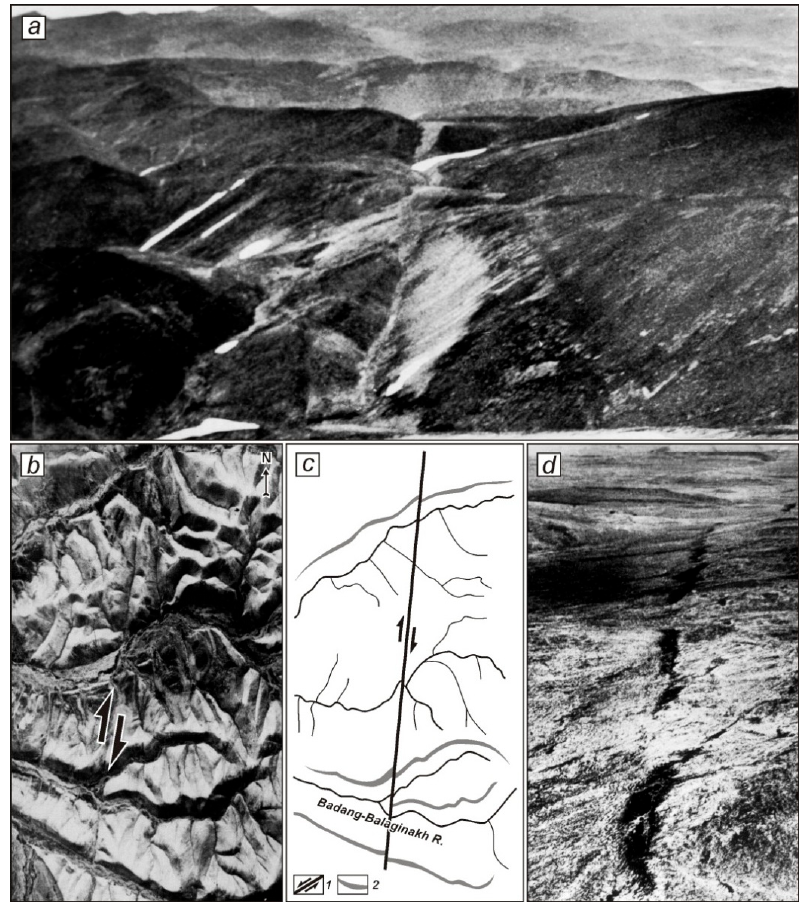
Figure 5. Seismodislocation Beris (after [21]). ( a ) Photograph of surface ruptures resulting from the Bulun earthquakes of 1927–1928 (M ≥ 7.0); ( b ) aerial photograph of the Beris fault scarp, arrows point to the fault; ( c ) fragment of the deciphered image (1—strike-slip fault; 2—watershed axis); ( d ) photograph of seismogenic extension ruptures in the Kharaulakh fault zone (original location of the Beris